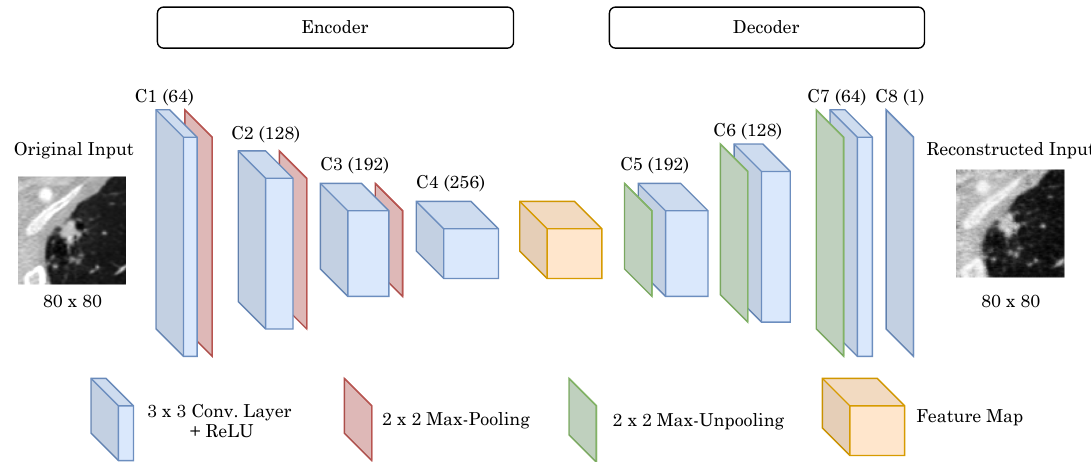
Figure 3. Proposed CAE architecture for lung nodule unsupervised feature learning by optimizing input